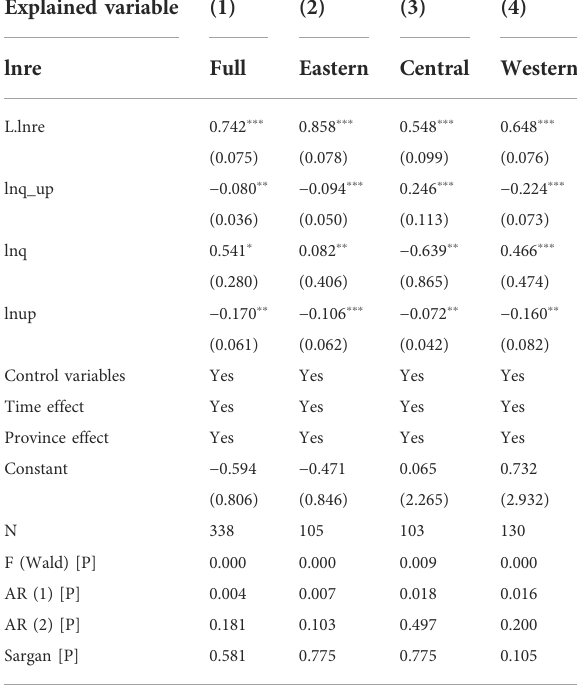
TABLE 2 Estimation results of urban scale in fl